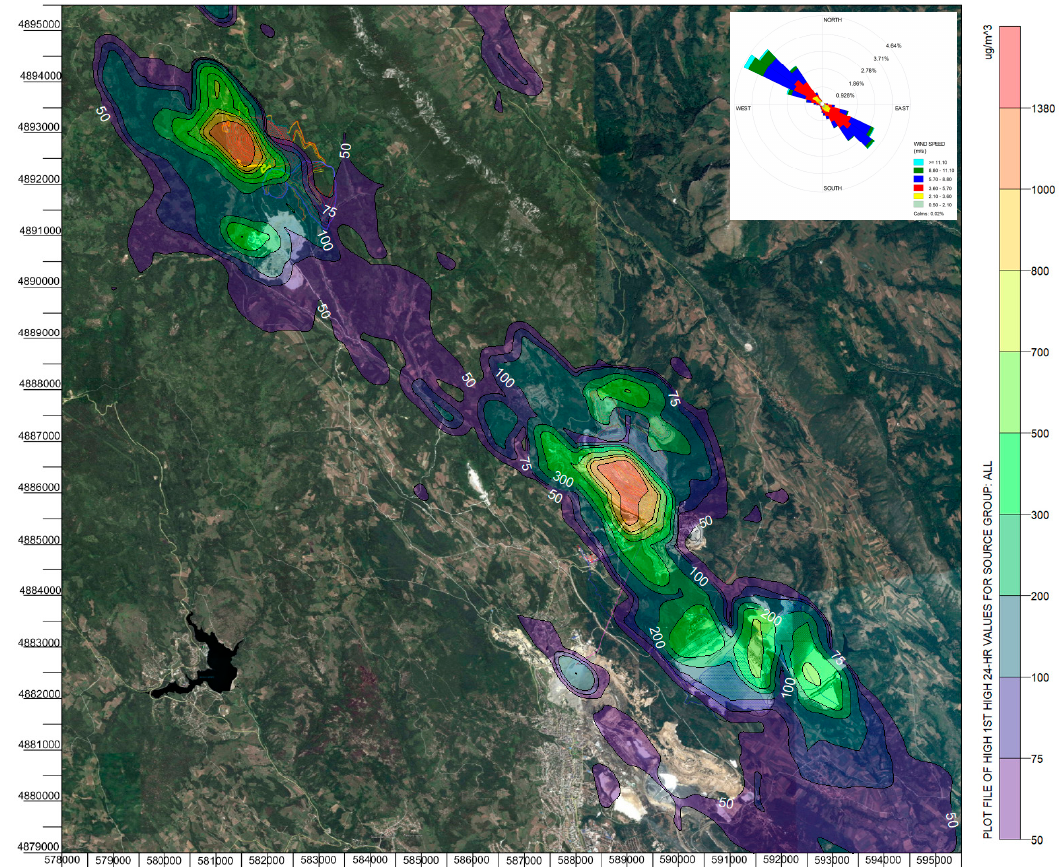
Figure 5. Distribution of PM10 ( μ g/m 3 ) particles concentration around the Veliki Krivelj and Cerovo open pits, without dust suppression and mitigation measures. PM10, particles with an aerodynamic diameter smaller than 10 μ m.